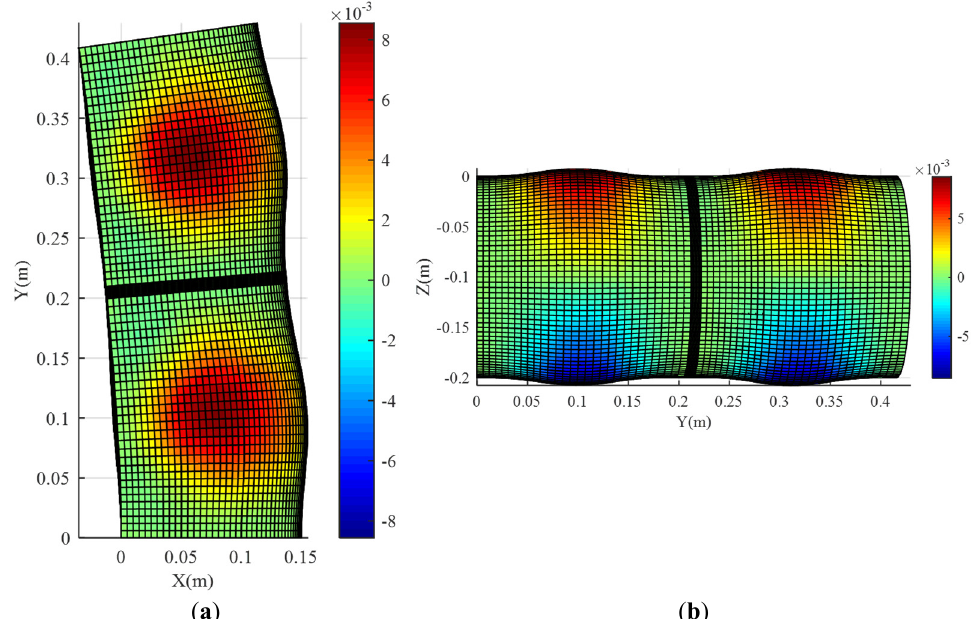
Figure 15. The deformation of two chambers under the pressure of 10 kPa . ( a ) Front view; ( b ) right view.